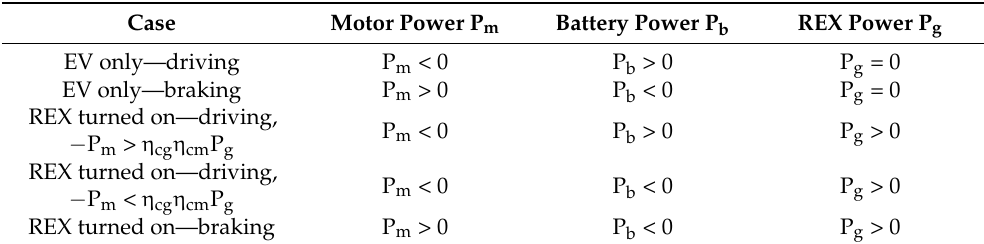
Figure 5. Illustration of power flow possibilities between electric motor, battery, and range extender. Table 1. Power flow for specific cases between motor, battery, and REX, as described in Equation (18). Power of sources is greater than zero, power of receivers is less than